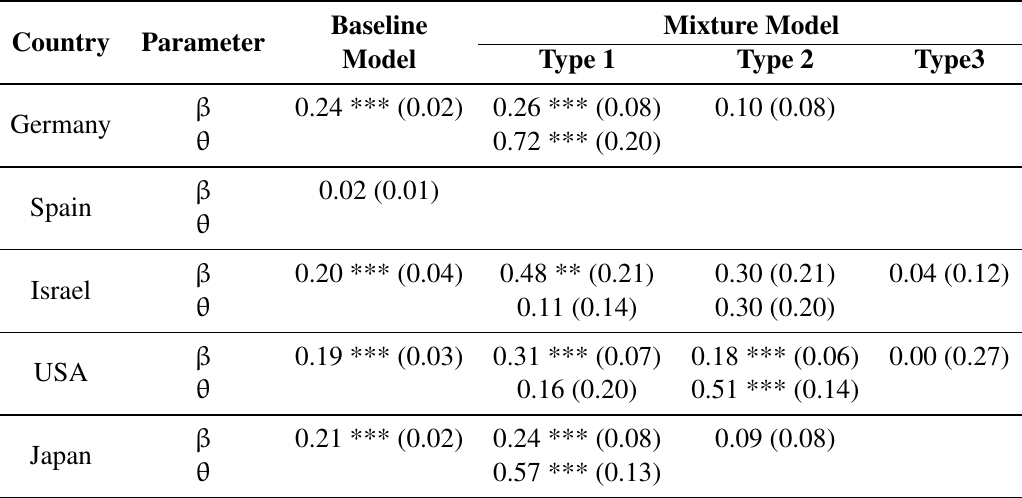
Table 4. Estimates of the aversion to advantageous inequity